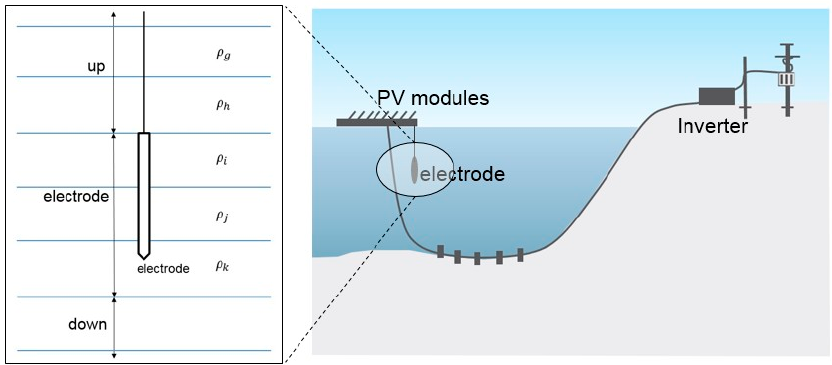
Figure 5. Design for an underwater grounding system for a floating PV (Photovoltaic) system.